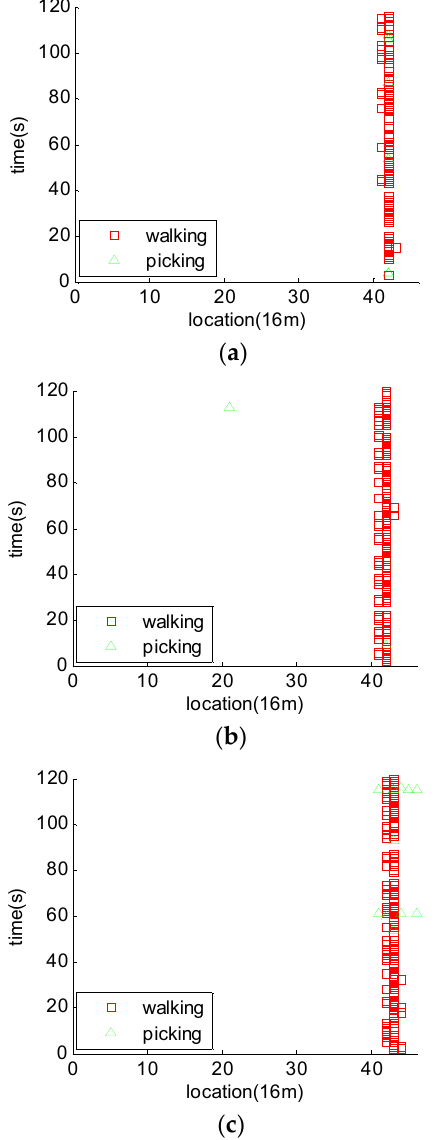
Figure 18. The identification results of walking signals. ( a ) The first group of walking signals; ( b ) The second group of walking signals; ( c ) The third group of walking signals.